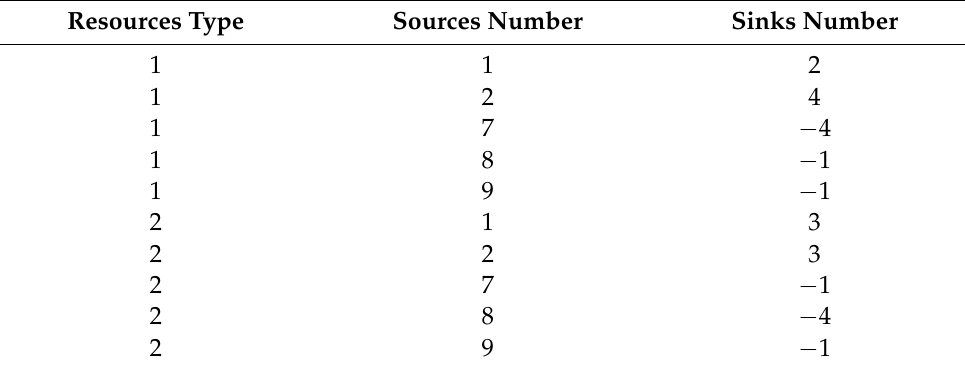
Table 2. Resource scheduling initial data